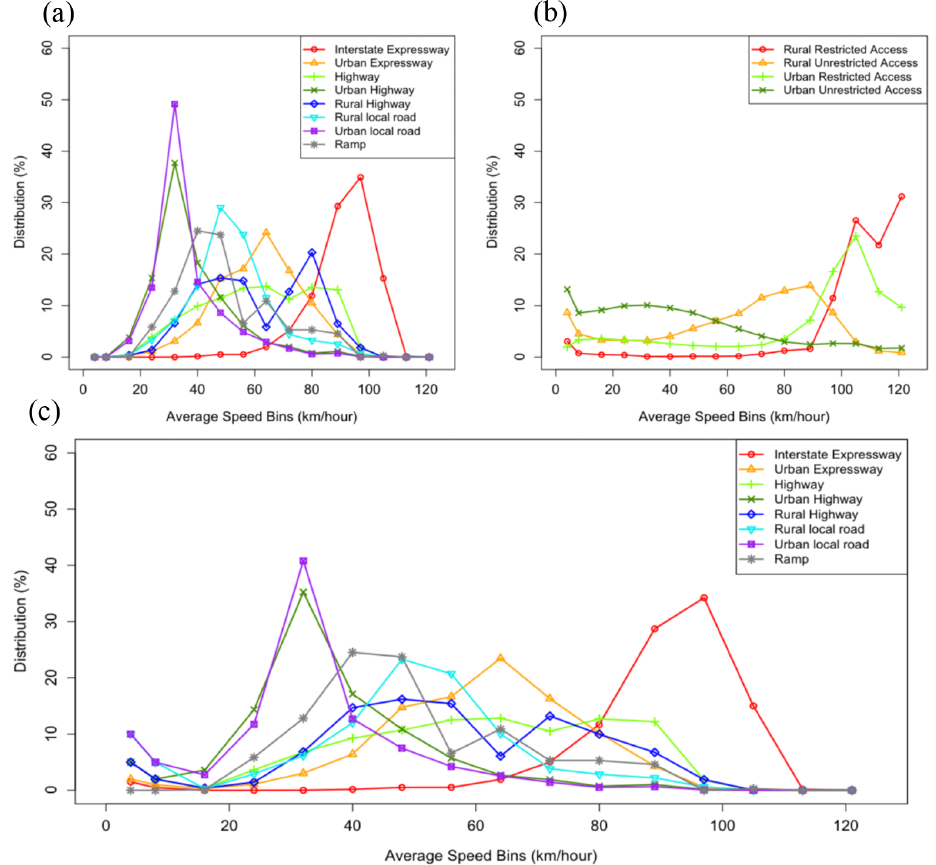
Figure 4. (a) South Korean speed distribution by road type. (b) The speed distribution by road type for the state of Georgia (US). (c) The average speed distribution (ASD) by road type used in this study for South Korea.